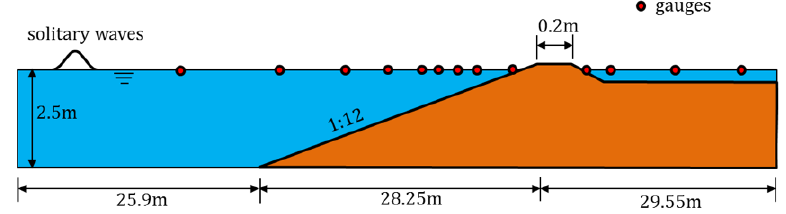
Figure 7. The experimental setup and bottom geometry for propagation of solitary wave over fringing